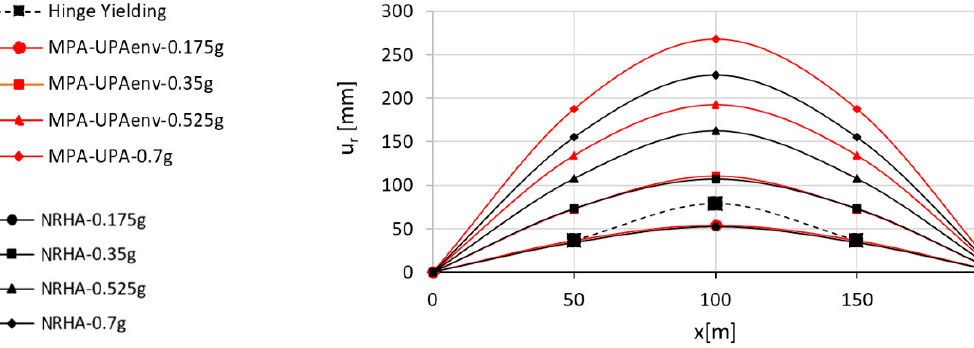
Figure 14. Regular bridge—deck displacements derived by performing nonlinear dynamic analysis and pushover analysis according to the approaches considered (PGA from 0.175 to 0.7 g).